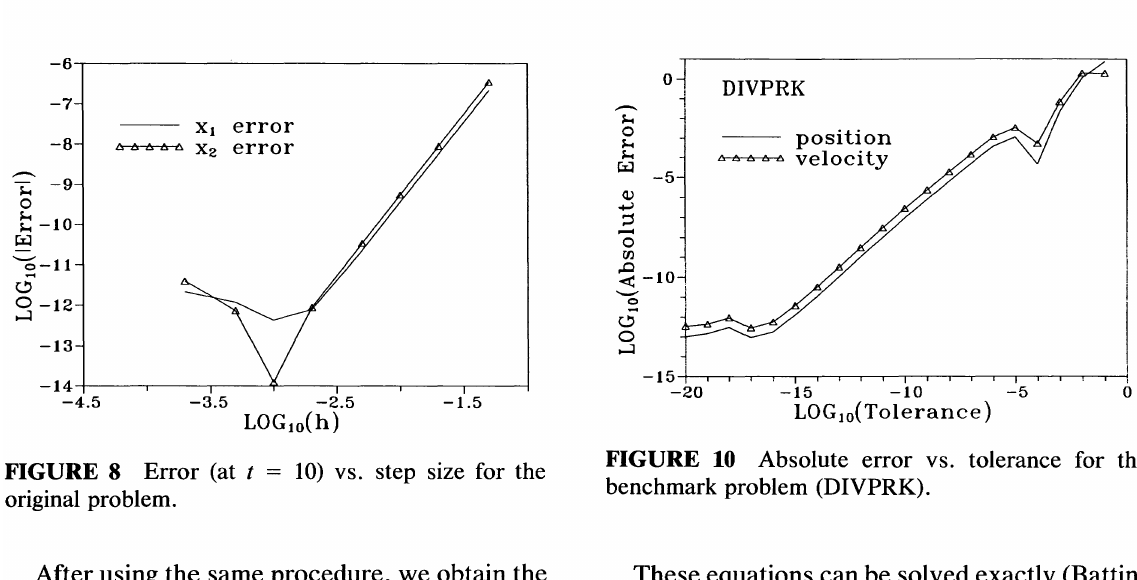
FIGURE 10 Absolute error vs. tolerance for the benchmark problem (DIVPRK).